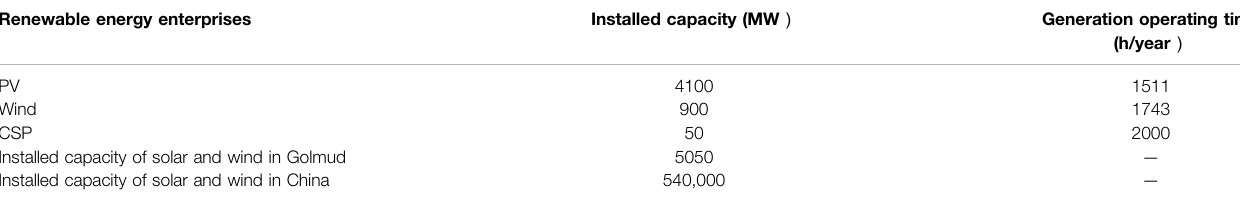
TABLE 2 | Installed capacity and electricity generator operating time data of renewable energy enterprises in Golmud. Renewable energy